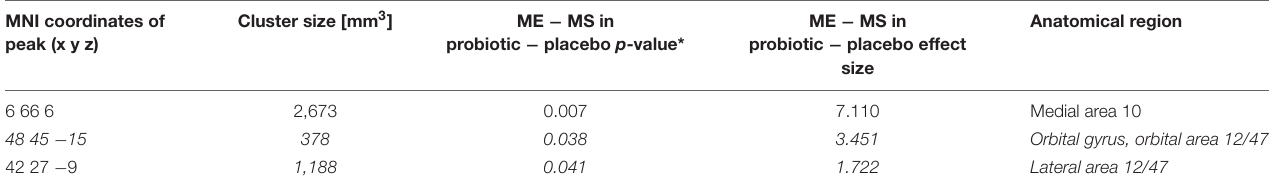
MNI coordinates of peak (x y